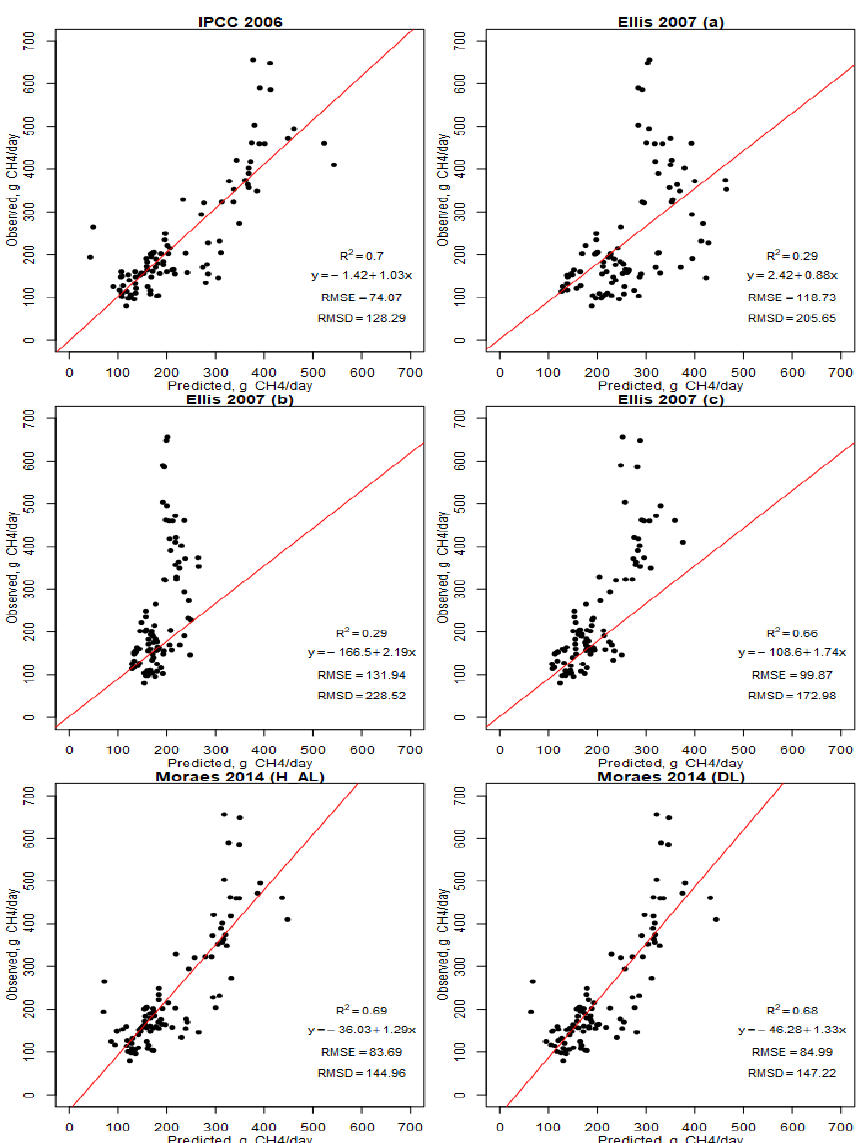
Figure 3. Observed vs. predicted CH 4 emissions value plots using 97 observations (black points) from 29 different studies in the six models selected. Regression lines are shown in red. RMSE: Root means square error; RMSD: Root means square deviation; and r 2 : Pearson’s coefficient.